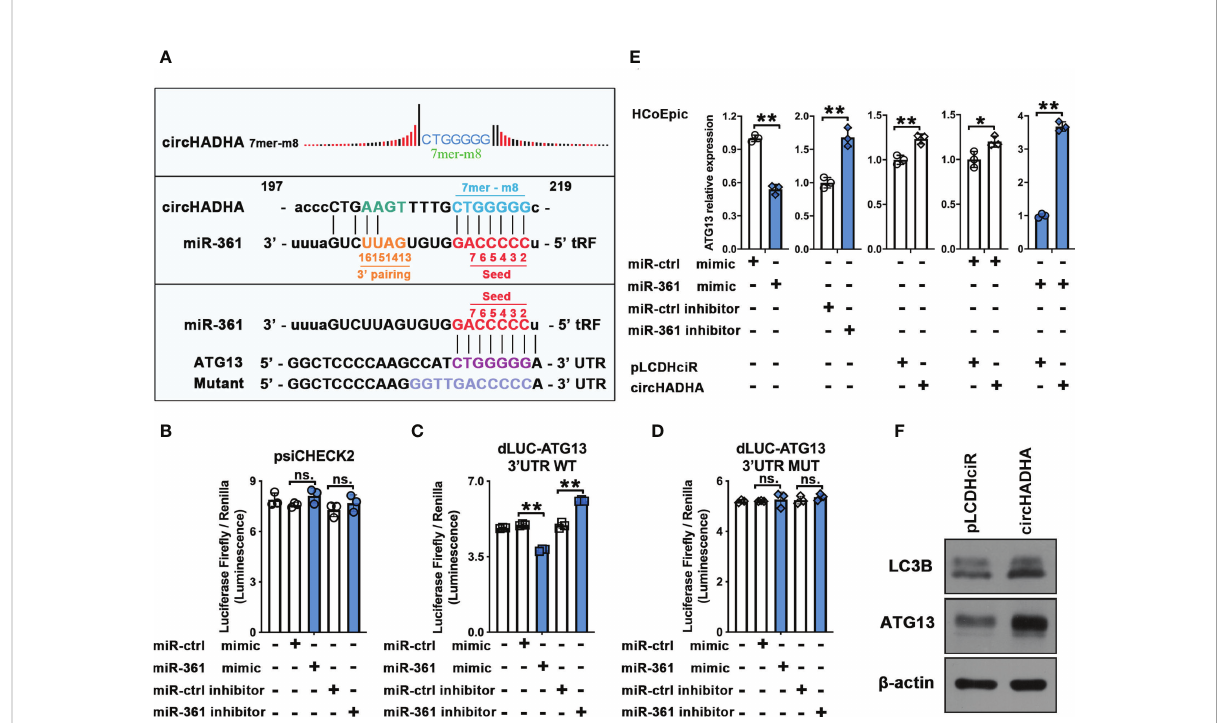
FIGURE 5 CircHADHA released ATG13 inhibition by competitively recruiting miR-361. (A) The sequence of potential binding sites in circHADHA (7mer-m8 position), seed region of miR-361, and 3 ’ UTR of ATG13. (B – D) The luciferase reporter between miR-361 and ATG13. (B) miR-361 did not regulate luciferase reporter activities of ATG13 in control HCoEpiC. (C) miR-361 mimic reduced, whereas miR-361 inhibitor increased, the luciferase activity of ATG13 compared with corresponding controls in HCoEpiC. (D) miR-361 did not regulate luciferase reporter activities of ATG13 with mutant in 3 ’ UTR in HCoEpiC. (E) The measurement of ATG13 relative expression transfected by miR-361 with or without circHADHA overexpression. (Left panels) miR-361 negatively regulated ATG13 expression compared with corresponding controls in HCoEpiC. (Central panel) circHADHA overexpression increased ATG13 expression compared with corresponding control in HCoEpiC. (Right panels) circHADHA overexpression elevated ATG13 expression regardless of the transfection with miR-361 or control mimic. (F) Overexpression of circHADHA increased LC3B II and ATG13 expression at protein level by Western blot. Three independent experiments were performed. ** P < 0.01; * P < 0.05; ns, no signi fi cant